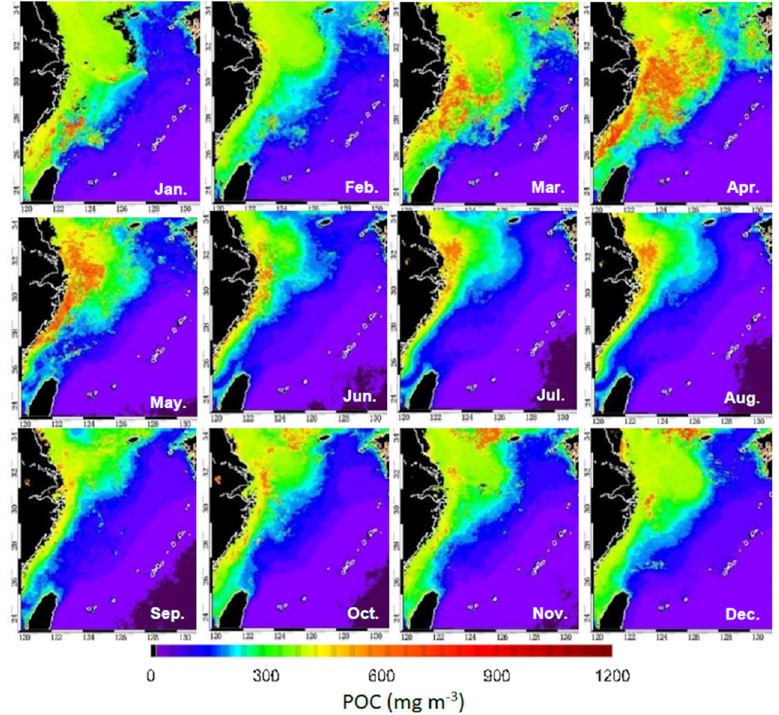
Figure 3. Monthly averaged POC horizontal distribution in the ECS from 2001–2011. The averaged POC also showed strong spatial variability, as shown in Figure 3. Concentration decreased from coastal region to open sea region, with year-round low POC concentrations mostly appearing in the open sea region near the Okinawa Trough under the influence of the Kuroshio Current. High POC concentration (>600 mg m − 3 ) appeared around the coastal region, with the largest temporal variability due to the combined effects of primary productivity, terrestrial runoff and physical processes. High POC was observed in spring, which was consistent with observational studies suggesting that POC concentrations are dominated by biological activity due to high nutrients supply by terrestrial input and upwelling [27]. POC decreased in summer, despite high river discharge from sources including the Changjiang Estuary transporting higher quantities of POC from terrestrial runoff into the coastal region [42]. The large volume of freshwater induced stronger stratification, preventing nutrients and oxygen exchange between upper and deeper oceans [43]. A combination of insufficient nutrient supply to phytoplankton growth and continuous consumption by zooplankton and bacteria led to the reduction of